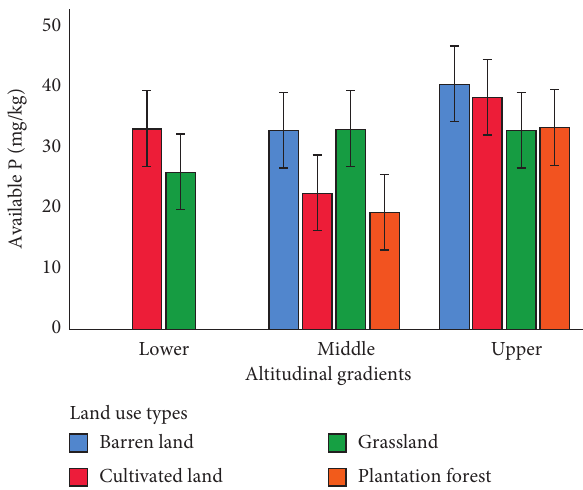
Figure 6: Effects of land use type and altitudinal gradient on available phosphorus at the Ayiba watershed.